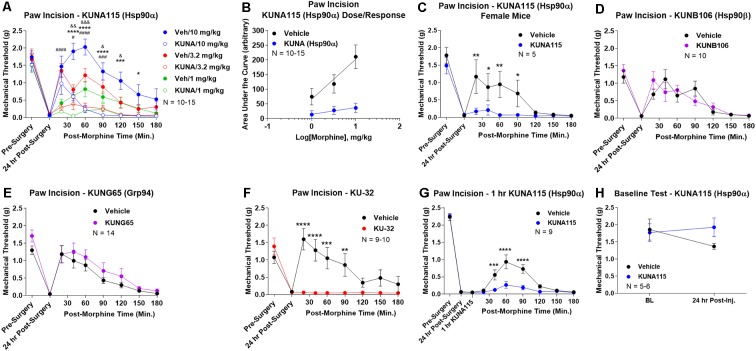
Heat shock protein 90 (Hsp90) isoform-selective inhibitor screen identifies Hsp90α in promoting opioid anti-nociception in the brain. CD-1 mice had the paw incision surgery performed, with concurrent injection of vehicle or 0.1 nmol of inhibitor intracerebroventricular (icv). Mice recovered 24 h, followed by sc injection of morphine. Mechanical thresholds measured before and after surgery, and in a time course after morphine injection. Pre- and post-surgery baselines did not differ for any group (p > 0.05). All data reported as the mean ± SEM, with sample sizes of mice/group noted in each graph. All statistics performed by two-way ANOVA with Fisher’s Least Significant Difference post hoc test. (A) Male mice tested with KUNA115 (Hsp90α selective) and a 1–10 mg/kg morphine dose range. *,***,****p < 0.05, 0.001, 0.0001 between Veh and KUNA groups at same time point at 10 mg/kg; #,###,####p < 0.05, 0.001, 0.0001 between Veh and KUNA groups at same time point at 3.2 mg/kg; &,&&,&&&p < 0.05, 0.01, 0.001 between Veh and KUNA groups at same time point at 1 mg/kg. Performed in 2–3 technical replicates. (B) Dose/response curves constructed from the data in (A) and analyzed as described in “Materials and Methods” section. A50: Vehicle = 8.95 mg/kg; KUNA115 = 88, 139, 382 mg/kg (too flat for accurate calculation). (C) KUNA115 experiment performed in female mice with 3.2 mg/kg morphine. Performed in one technical replicate. For remaining graphs: *,**,***,****p < 0.05, 0.01, 0.001, 0.0001 vs. same time point inhibitor treatment group. (D) Male mice tested with KUNB106 (Hsp90β selective) with 3.2 mg/kg morphine. Performed in two technical replicates. (E) Male mice tested with KUNG65 (Grp94 selective) with 3.2 mg/kg morphine. Performed in three technical replicates. (F) Male mice tested with KU-32 (non-selective) with 3.2 mg/kg morphine. Performed in two technical replicates. (G) Male and female mice had paw incision performed, with 23 h recovery. KUNA115 or Vehicle then injected as above, with 1 h treatment prior to 3.2 mg/kg morphine. Performed in two technical replicates. (H) Male and female mice had KUNA115 or Vehicle injected as above with a 24 h recovery. Pre- and post-injection baselines measured without any surgery, pain state, or opioids present. Performed in two technical replicates by different experimenters.